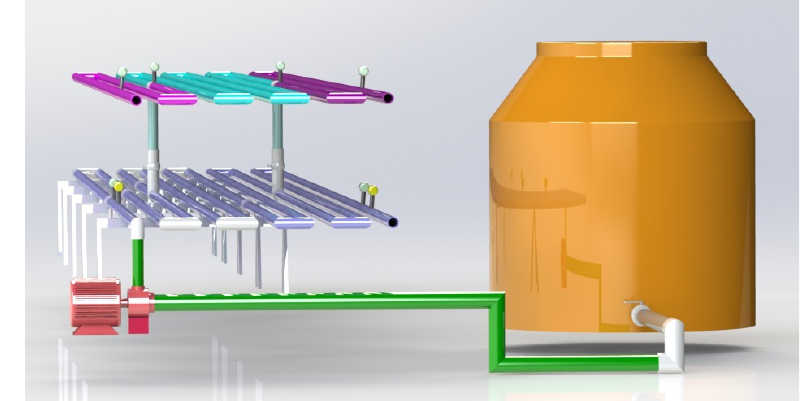
Figure 3. Sectioned hydraulic network configuration.